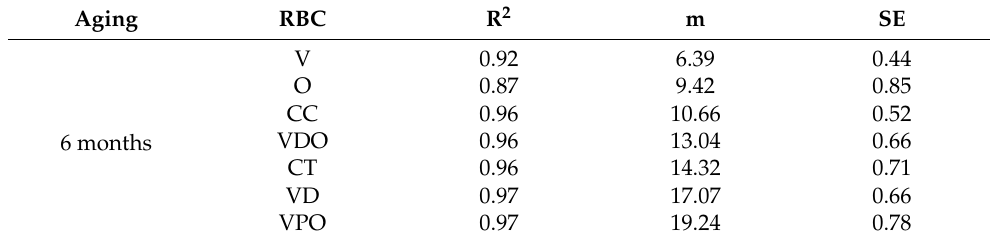
Figure 5. Example of a Weibull plot representing the empirical cumulative distribution function of strength data at 24 h post-curing. Linear regression was used to numerically assess the goodness- of-fit and estimate the parameters of the Weibull distribution, as described in Table 2.